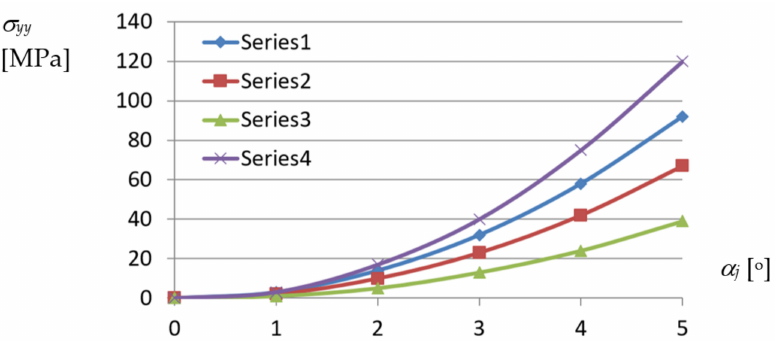
Figure 21. Relations between σ yy normal stresses acting orthogonally to longitudinal axes and α j unit angle of the transformed sheets of the following profiles: Series1—TR50 × 0.75 mm × 6.2 m; Series2—TR60 m × 0.75 mm × 6.2 m; Series3—TR130 × 0.75 mm × 6.2 m; Series4—TR85 × 0.75 mm × 5.0 m.